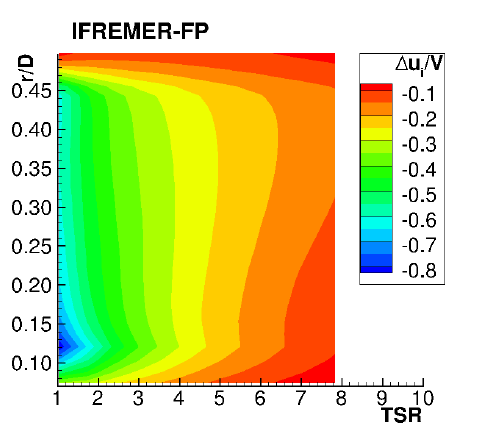
Figure 7. IFREMER-FP turbine. Calculated axial induced velocity distribution at rotor